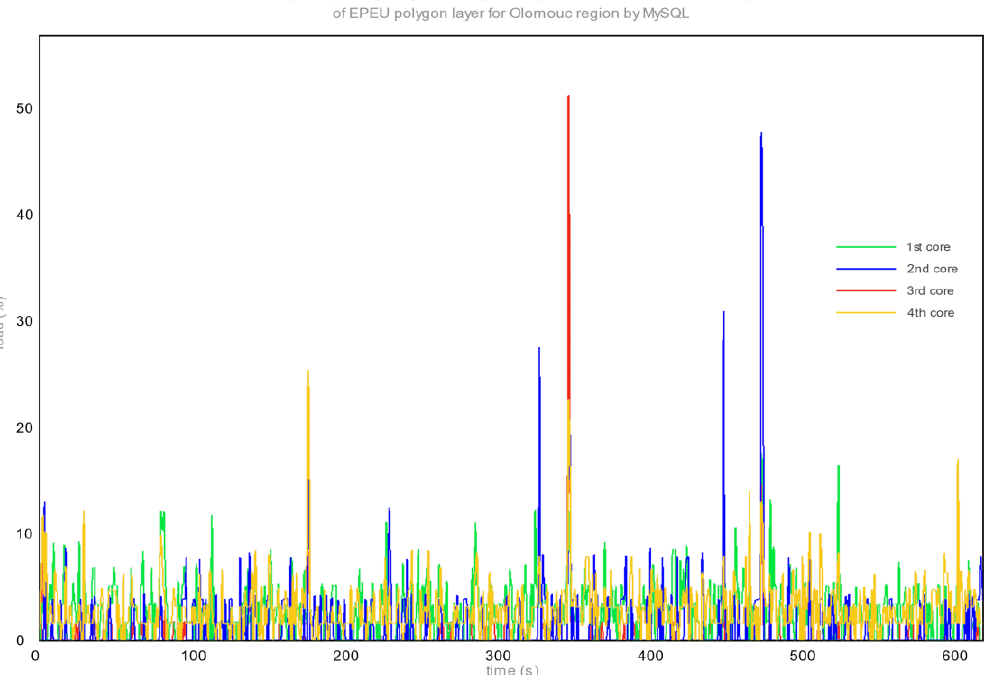
Figure 4. CPU core load during replication of EPEU layer by MySQL.